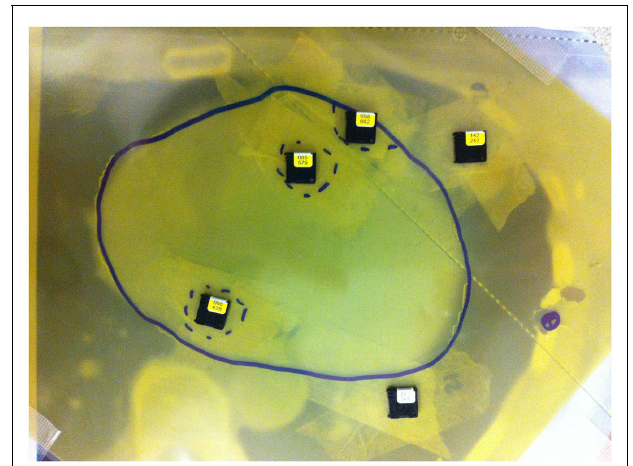
PLACEMENT OF DOSIMETERS